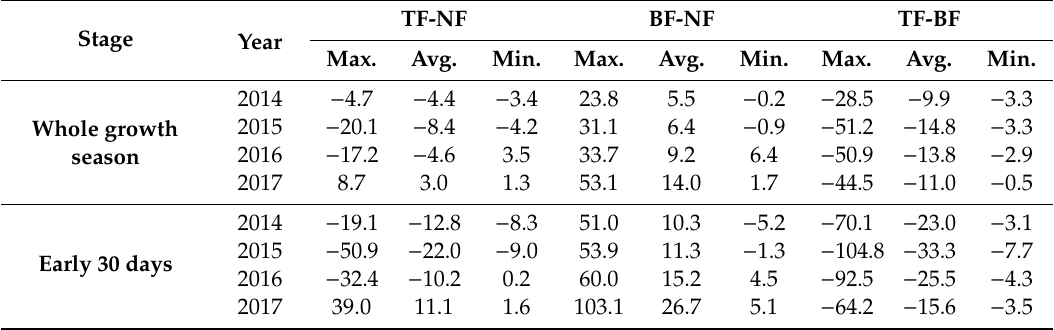
Table 2. The soil heat flux (G) (daily maximum G, daily average G, and daily minimum G) di ff erences between di ff erent treatments: black film (BF), no film (NF), and transparent film (TF) at 10 cm soil depth in the whole growth season and the early 30 days after potato growing in 2014–2017. TF-NF BF-NF TF-BF Stage Year Max. Avg. Min. Max. Avg. Min. Max. Avg. Min. Whole growth